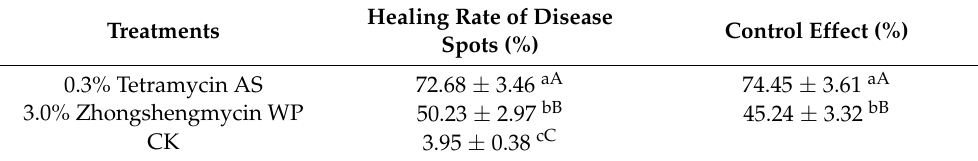
Table 2. The control effects of tetramycin and zhongshengmycin on canker disease of